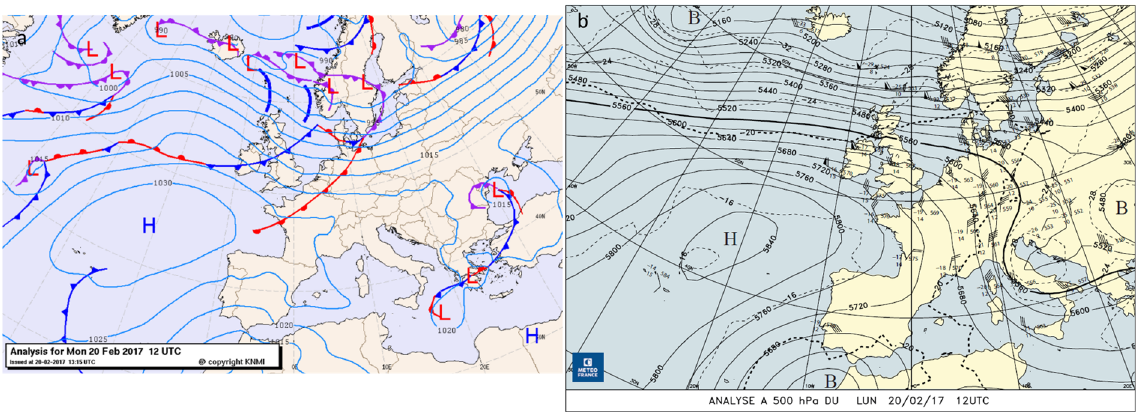
Figure 3. Synoptic situation at the beginning of the IOP: sea level pressure chart ( a ) and geopotential height (in meters) at 500 hPa ( b ). Plots originate from the KNMI ( a ) and MeteoFrance ( b ).